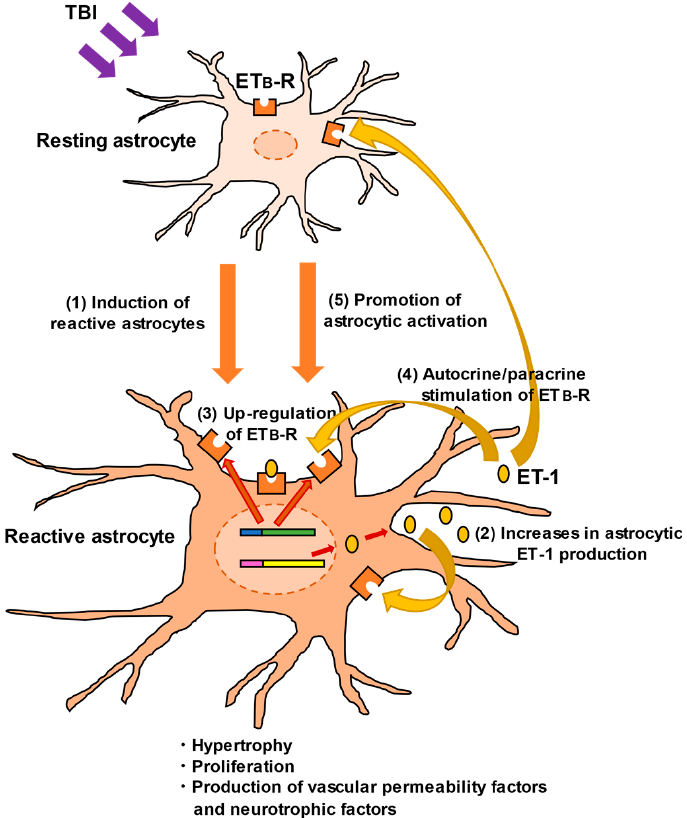
Figure 3. Promotion of astrocytic activation through ET-1/ET B -R signaling. In TBI, ET-1 induces reactive astrocytes through the following mechanisms: (1) TBI promotes the conversion of resting astrocytes to reactive ones. (2) ET-1 is produced and released from reactive astrocytes. The physical impact of TBI directly stimulates ET-1 production, although the mechanism is unclear [27,31]. (3) As well as ET-1, expression of astrocytic ET B -R is upregulated, accompanied by astrocytic activation. (4) Astrocyte-derived ET-1 stimulates ET B -R through an autocrine/paracrine mechanism. (5) ET B -R stimulation further promotes conversion to reactive astrocytes and enhances their functions.